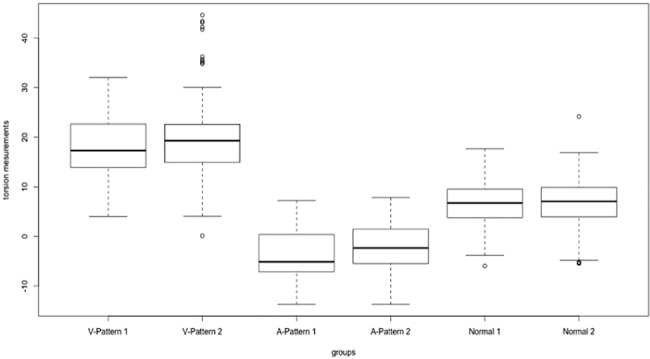
Boxplots representing variability of disc-foveal angle measurements (in degrees) over times: NMFP 1 and NMFP 2 and subgroup: V-Pattern, A-Pattern and healthy children.